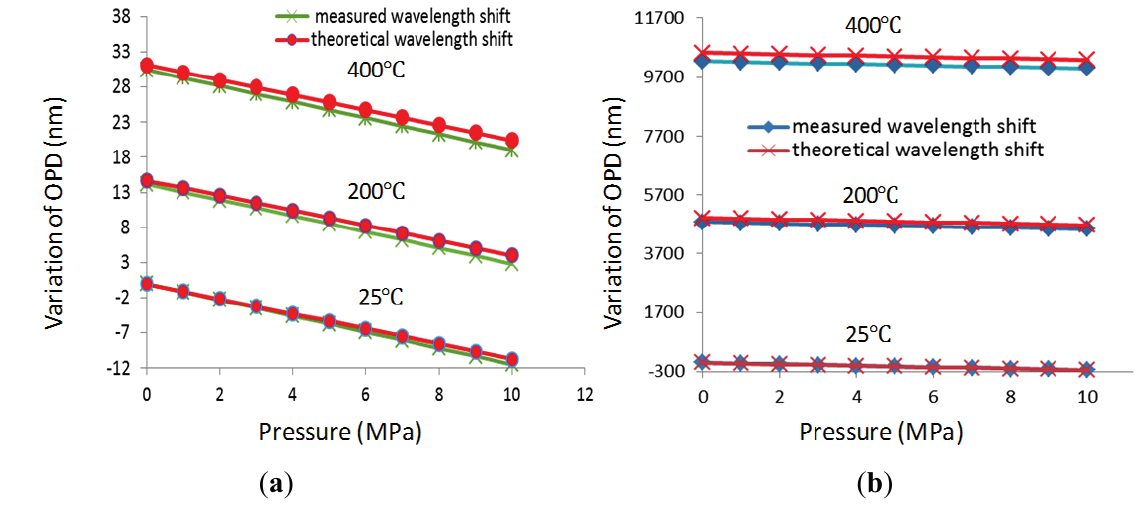
Figure 7. Variation of OPDs with pressure at different temperature ( a ) cavity 1 and ( b ) cavity